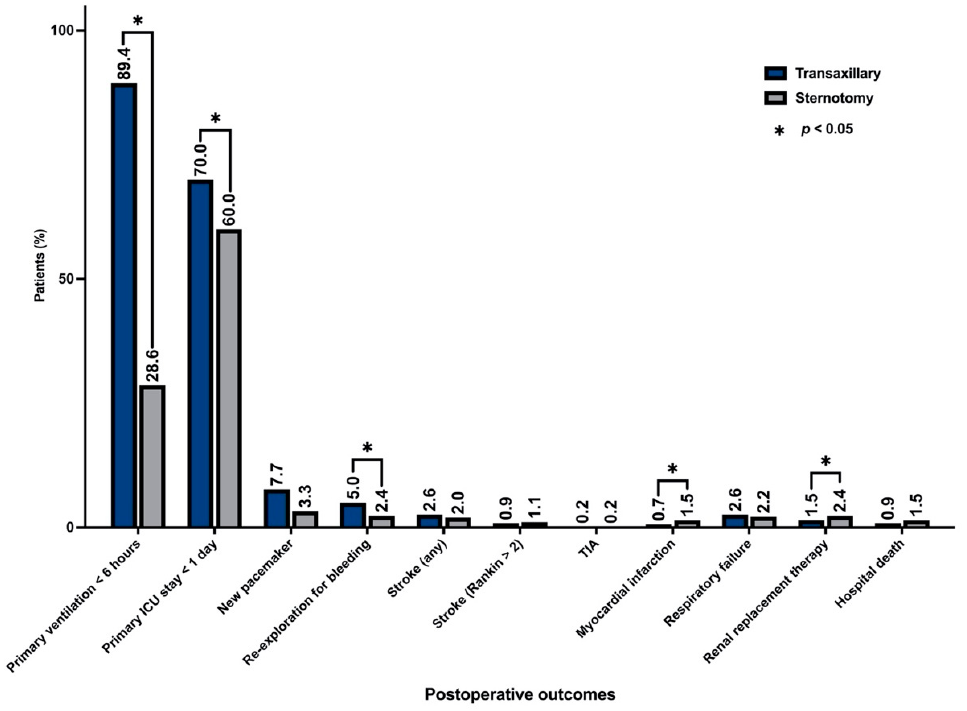
Figure 4. Main postoperative outcomes.